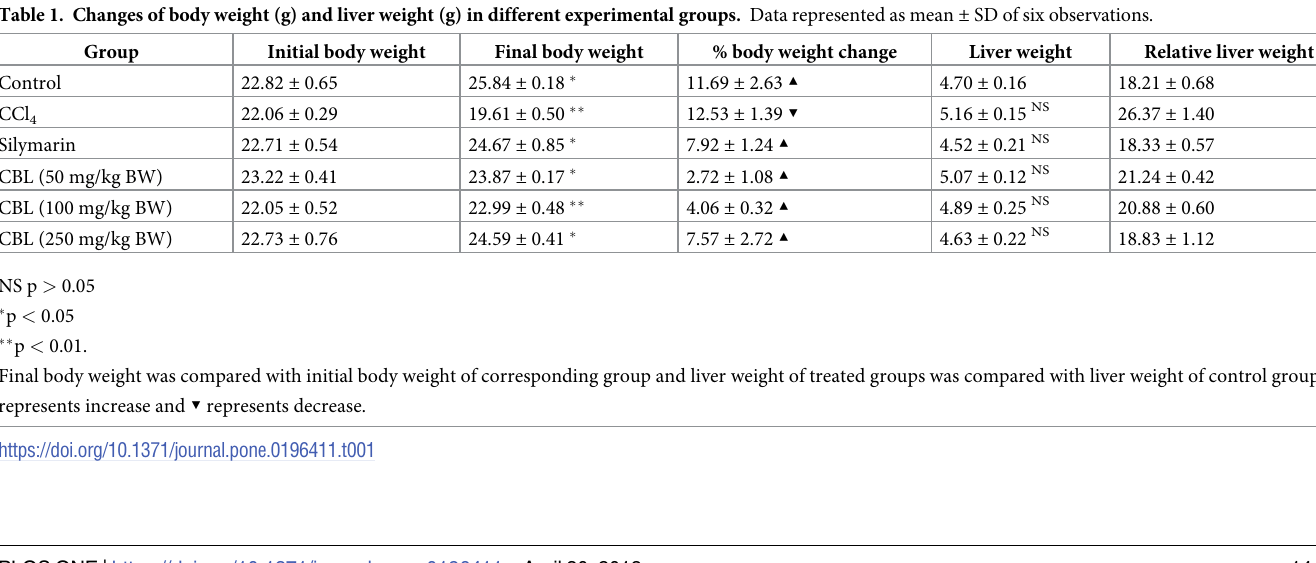
Table 1. Changes of body weight (g) and liver weight (g) in different experimental groups. Data represented as mean ± SD of six observations.